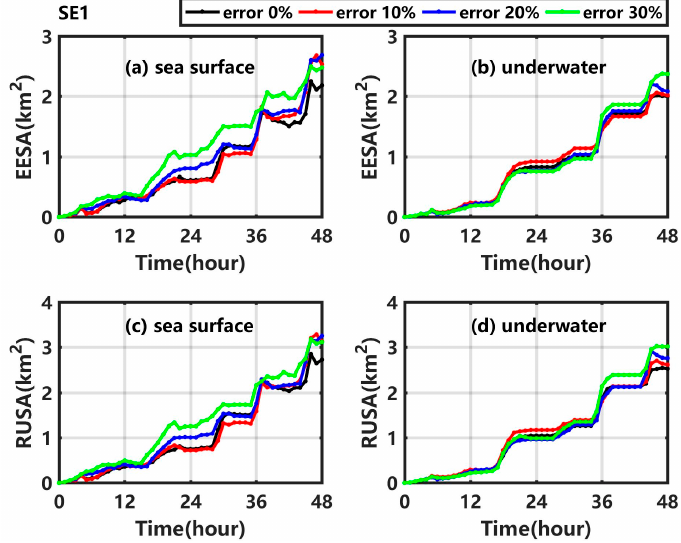
Figure 5. ( a ) EESA at the sea surface, ( b ) underwater EESA, ( c ) RUSA at the sea surface and ( d ) underwater RUSA in Exp1 (black line), SE1_1 (red line), SE1_2 (blue line), and SE1_3 (green line). The error expectation of sweeping volume (EESV) and the result uncertainty of sweep- ing volume (RUSV) are calculated and shown in Figure 6. The EESV (RUSV) gradually increases with time in SE1_1, SE1_2, and SE1_3; in addition, the maximum value at 48 h is 0.54 km 3 (0.72 km 3 ), 0.66 km 3 (0.81 km 3 ), and 0.80 km 3 (0.94 km 3 ). With the increase of the uncertainty in wind, the average error (uncertainty degree) of the sweeping volume increases by 0.00 times (0.01 times), 0.12 times (0.14 times), and 0.47 times (0.32 times) in SE1_1, SE1_2, and SE1_3, respectively, compared with the value in